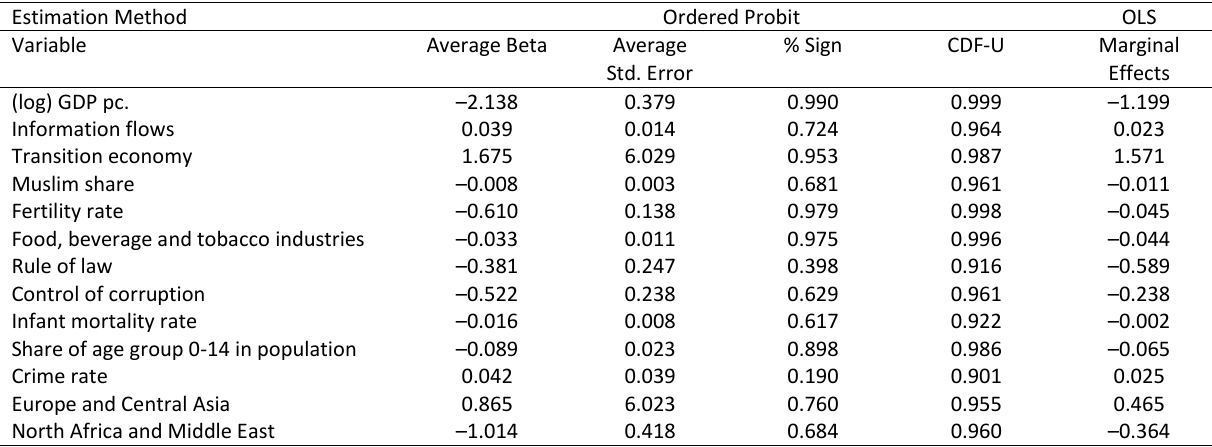
Table 1. Robust push